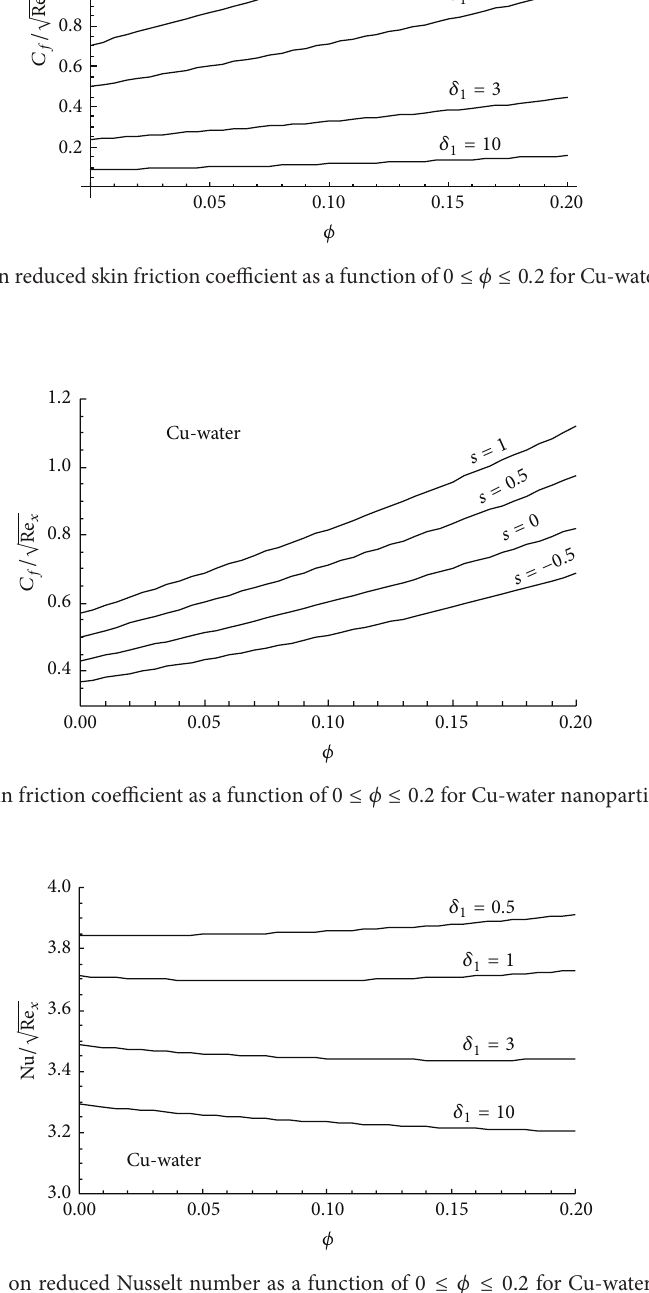
Figure 10: Effect of the first slip 𝛿 1 on reduced Nusselt number as a function of 0 ≤ 𝜙 ≤ 0.2 for Cu-water nanoparticles when 𝑃𝑟 = 6.2 , = 0 𝑠 = 0.5 , and 𝛿 2